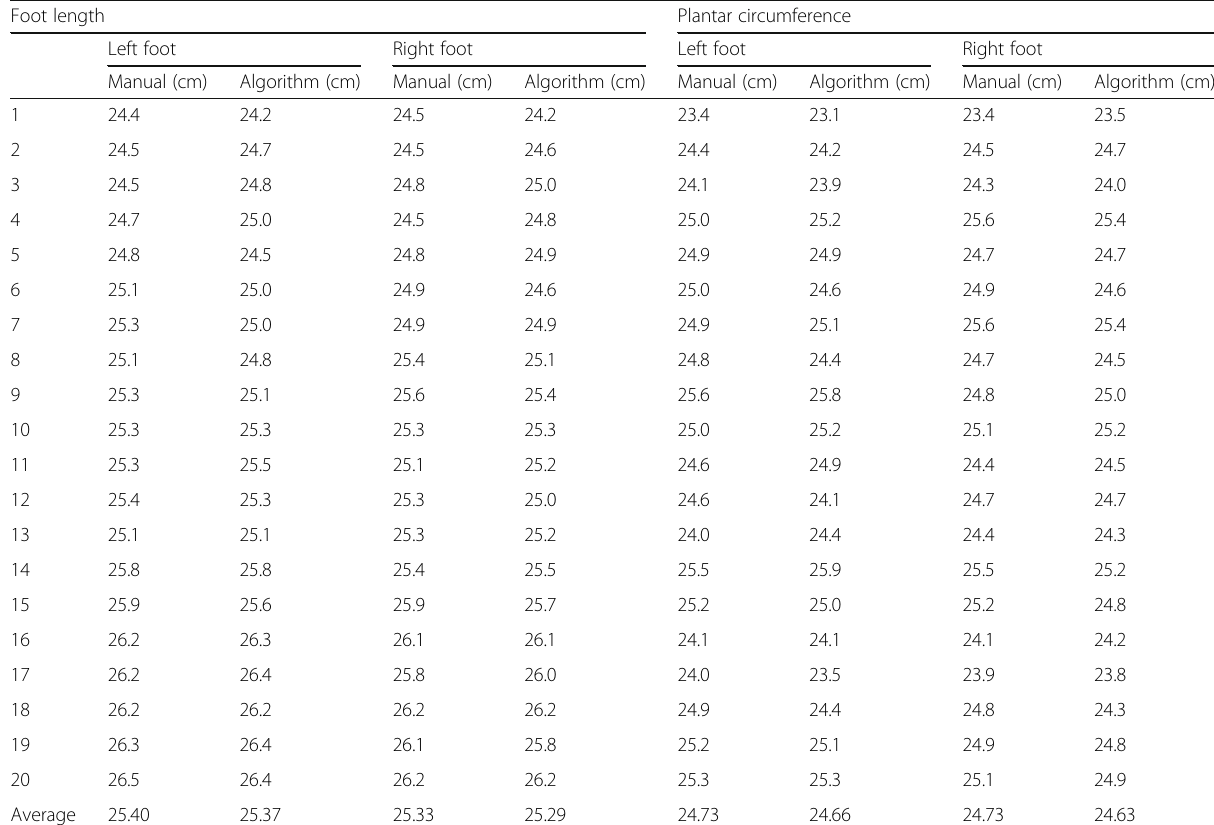
Table 3 Comparison of the results of the measurement algorithms and manual measurement Foot